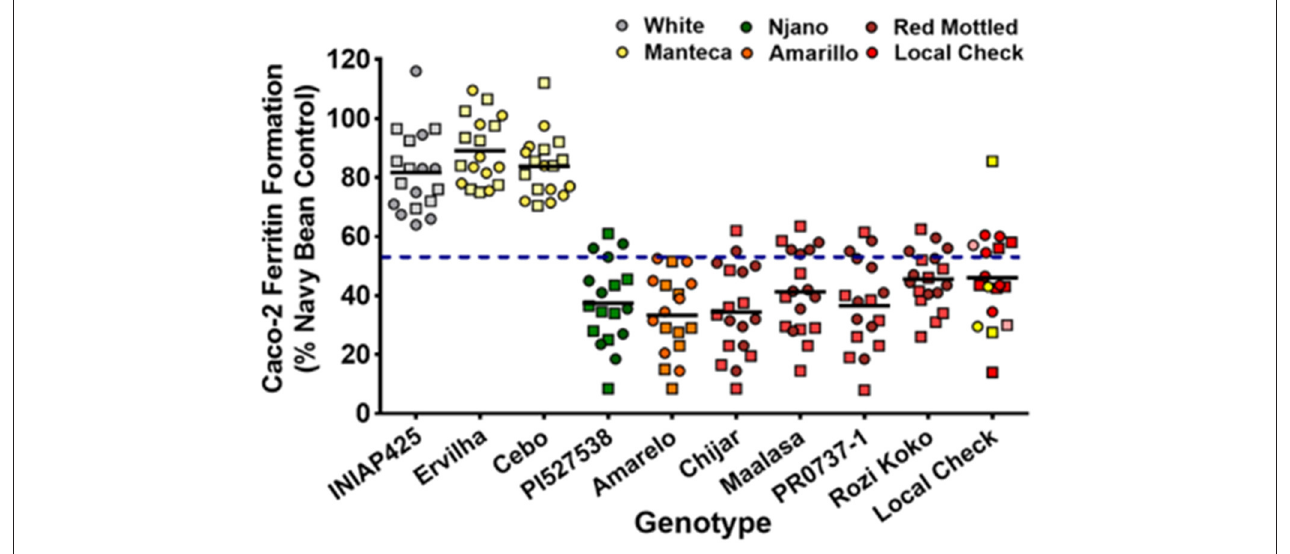
FIGURE 4 | Iron bioavailability of genotypes grown in nine locations across three agro-ecological zones in Uganda, field season 2015 (squares) and 2016